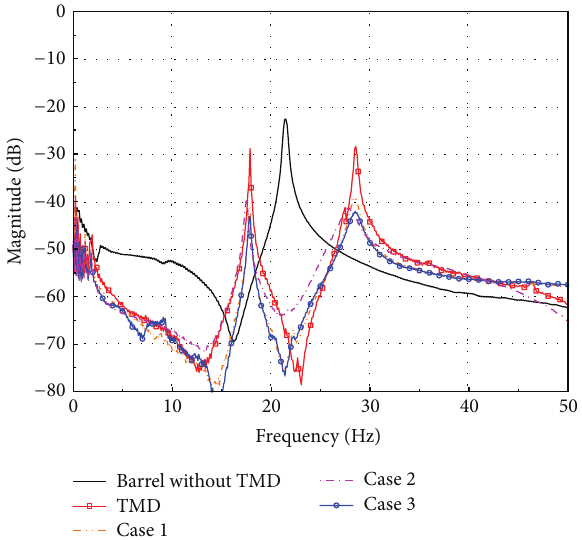
Figure 17: Frequency response functions of large beam structure with